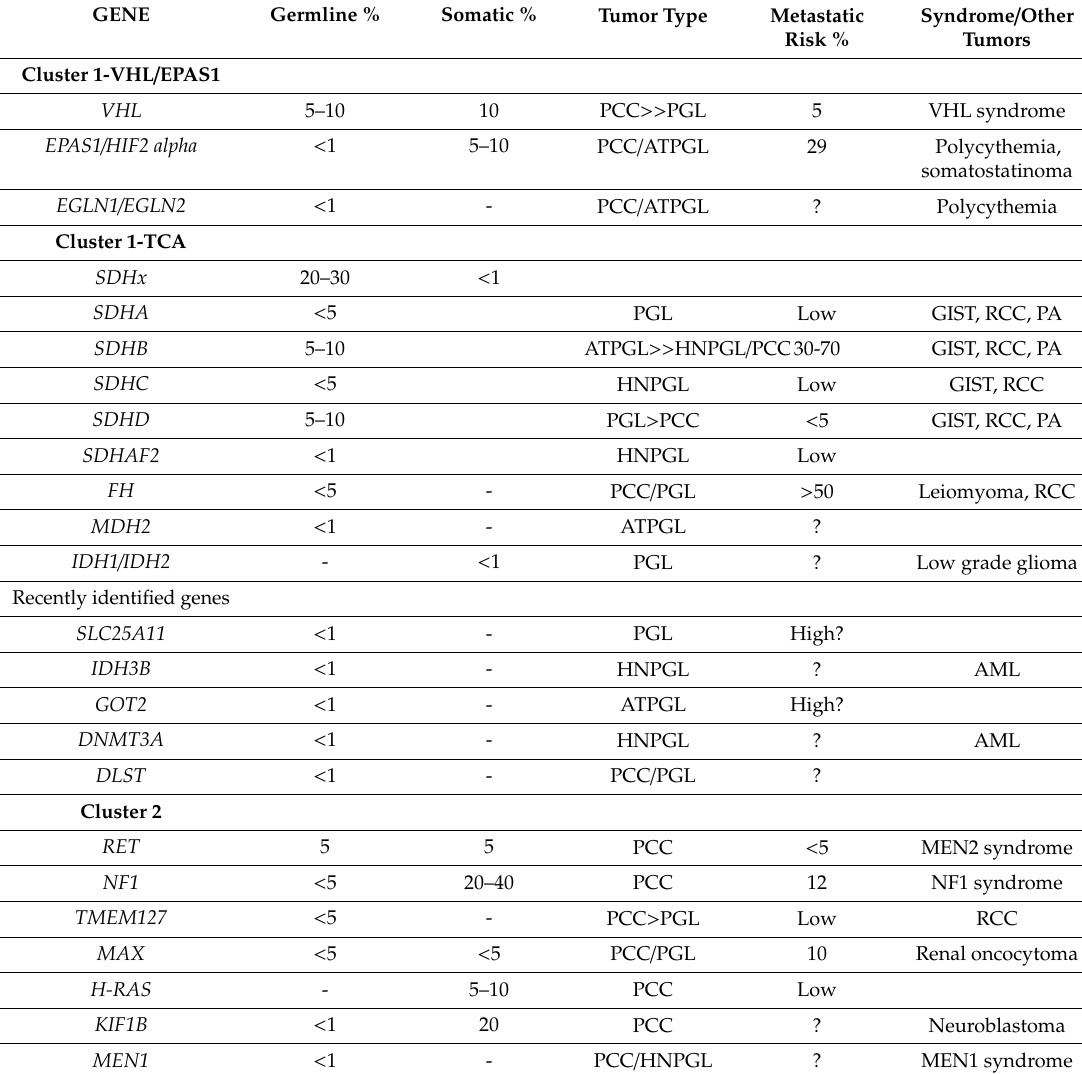
Table 1. Clinicopathologic and genetic characteristics of PCC / PGL-related